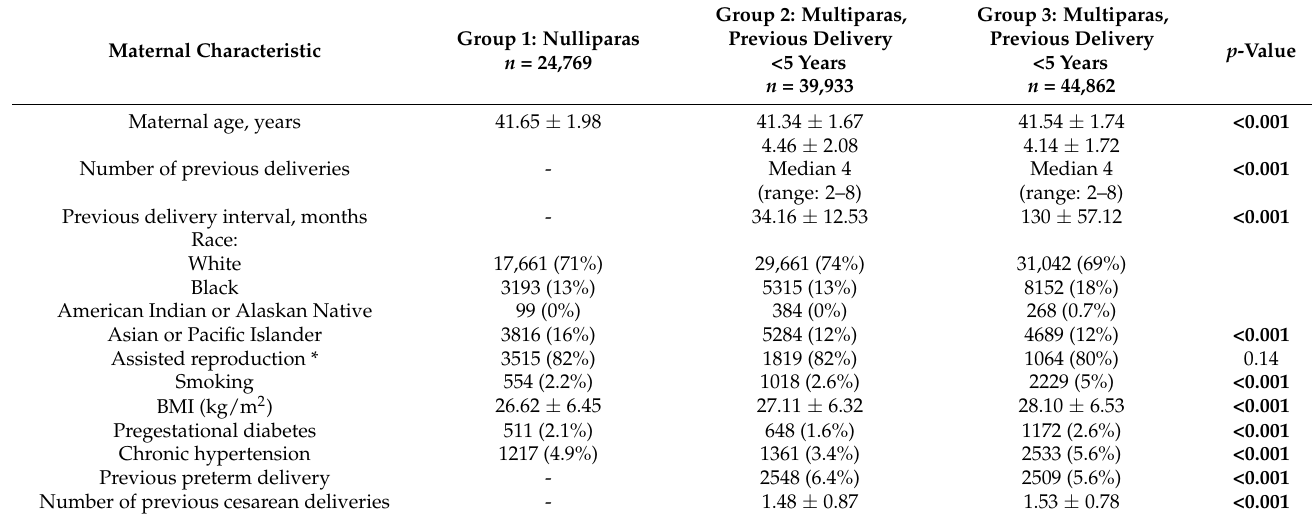
Table 1. Maternal characteristics stratified by parity and interval from previous delivery.